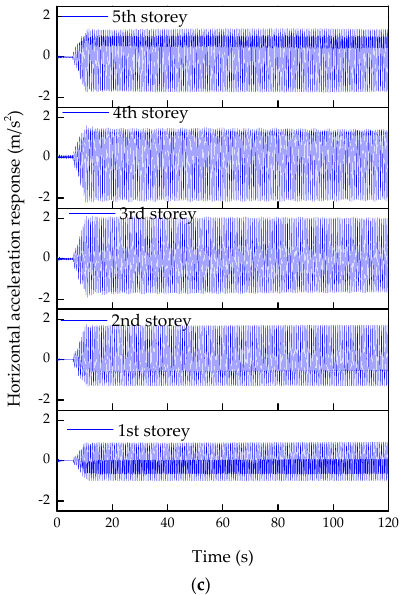
Figure 16. Horizontal acceleration responses of each story in damage cases: ( a ) case 1; ( b ) case 2; ( c ) case 3.